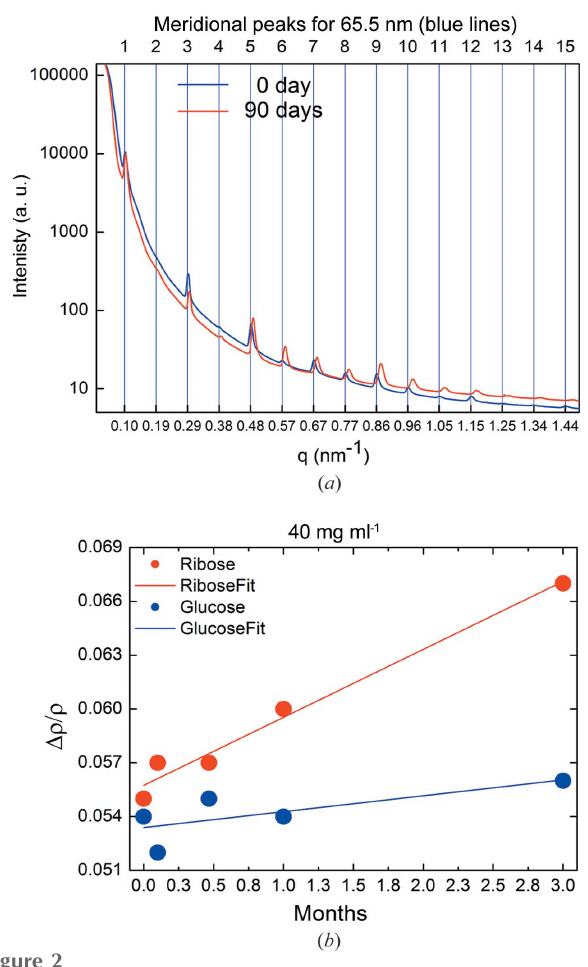
Figure 2 ( a ) SAXS profiles for collagen incubated in a ribose solution of 40 mg ml (cid:2) 1 at 3 (blue) and 90 days (red) (Giannini et al. , 2021). ( b ) Relative electron density difference ( (cid:2) (cid:4) ) determined for the collagen samples in solution with 40 mg ml (cid:2) 1 ribose (red dots) and glucose (blue dots), as a function of the incubation time, together with a linear fit of the data (straight